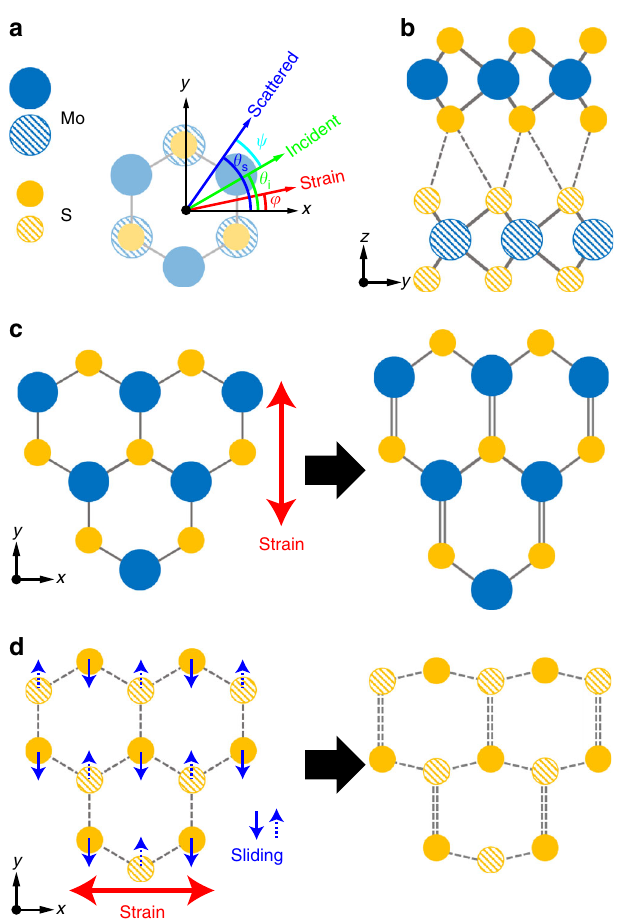
Fig. 1 Lattice structure of bilayer MoS 2 under uniaxial strain. a De fi nitions of angles. b Side view of crystal structure of bilayer MoS 2 . The atoms in the top layer are shown as solid circles, whereas those in the bottom layer are shown as hashed circles. c Top view of unstrained single-layer MoS 2 (left panel) and distorted lattice structure under armchair strain (right panel). Solid lines are for Mo – S covalent bonds. The double lines denote a longer bond distance compared to the single line. d Top view of hexagonal network of interface sulfur atoms in unstrained bilayer MoS 2 (left) and distorted lattice structure under zigzag strain (right). Sulfur atoms belonging to the upper (lower) layer are denoted by yellow fi lled (hashed) circles. The dotted lines indicate interlayer van der Waals bonds between interface sulfur atoms. Here, the double and single lines indicate the lengthened and shortened interfacial sulfur bond distances, respectively. Zigzag strain in single-layer MoS 2 and armchair strain in bilayer MoS 2 induce similar lattice